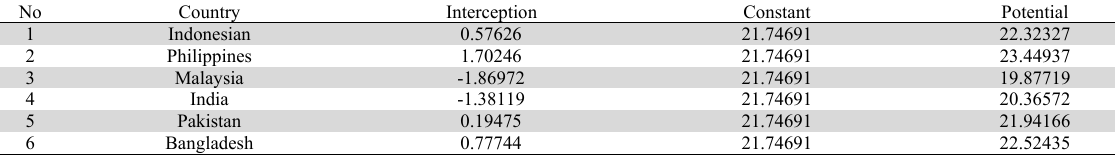
Foreign Direct Investment (FDI) Potential of 6 Southeast and South Asian Countries No